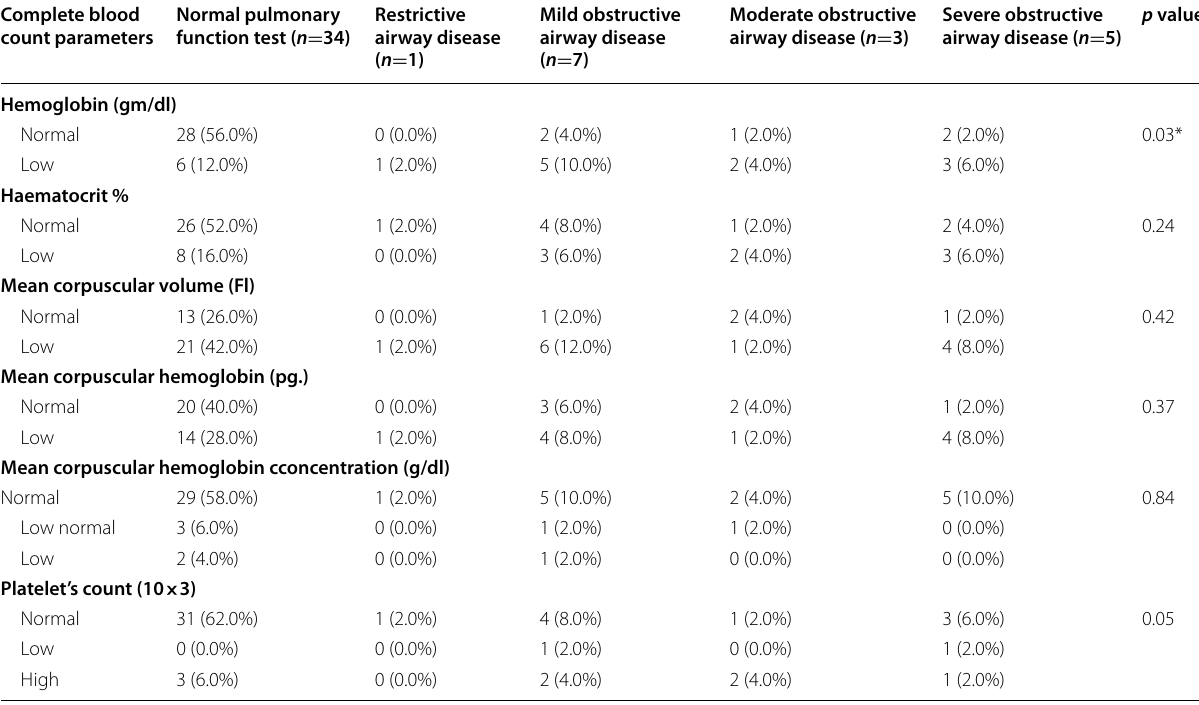
*p value <0.05 significant